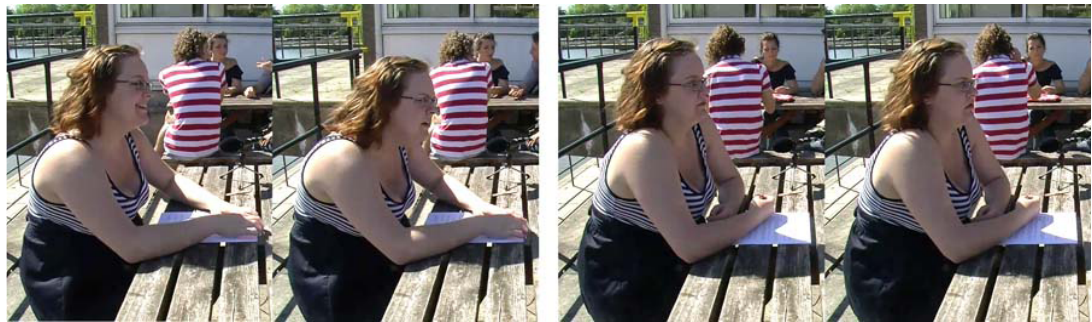
Figure 1. The pairs of images above show speaker B’s head position during T-1 and immediately after T0. The first pair illustra- tes a forward head extension and would be coded as “yes” while the second pair illustrates no relevant movement of the head or body and would therefore be coded as “no”.